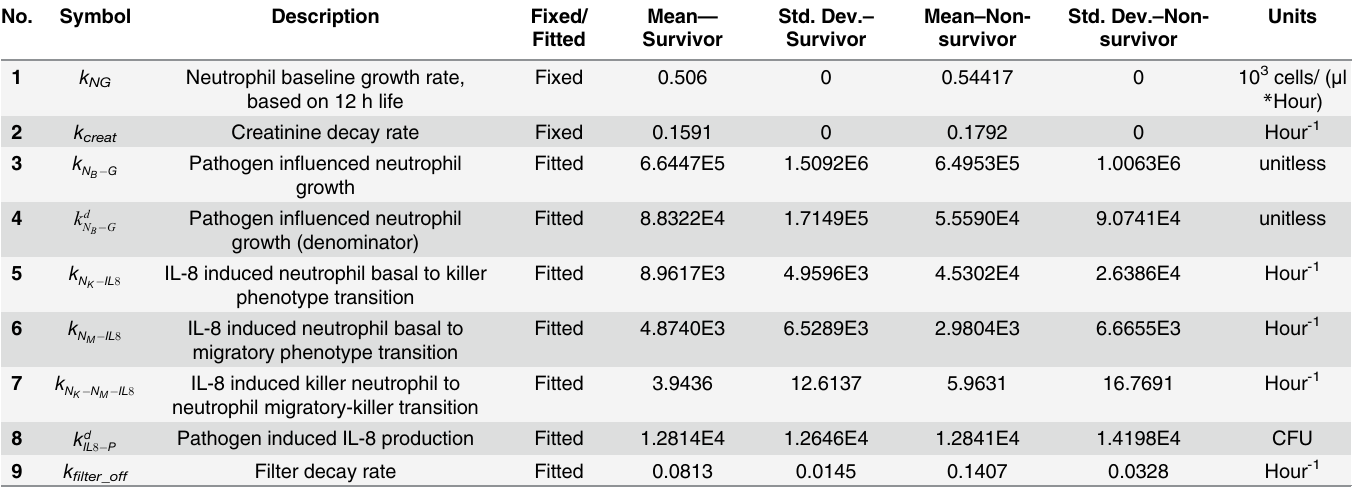
Table 3. Unique parameter